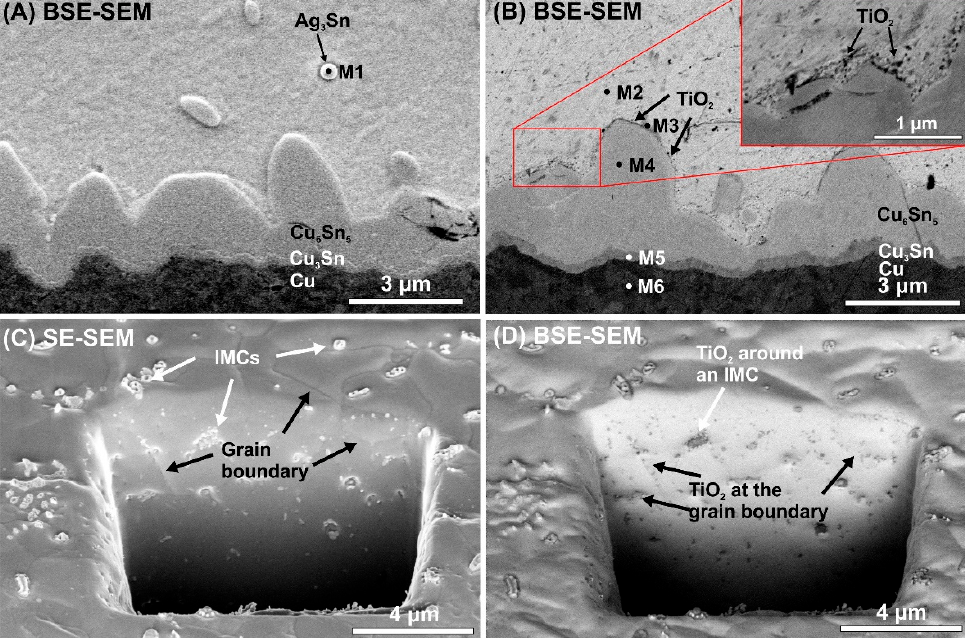
Figure 6. Locations of TiO 2 nano-particles in the solder matrix: ( A ) BSE-SEM micrograph of cross-sectioned SACX0307 sample at the bottom IMC layer; ( B ) BSE-SEM micrograph of a cross-sectioned SACX0307-nanoTiO 2 sample at the bottom IMC layer; ( C ) SE-SEM micrograph of a SACX0307-nanoTiO 2 sample in the solder bulk; ( D ) BSE-SEM micrograph of a SACX0307-nanoTiO 2 sample in the solder bulk. Table 1. Elemental composition of the measurement points M1–M6 in the solder joints. EDX Measurement Point / Element [at.%]